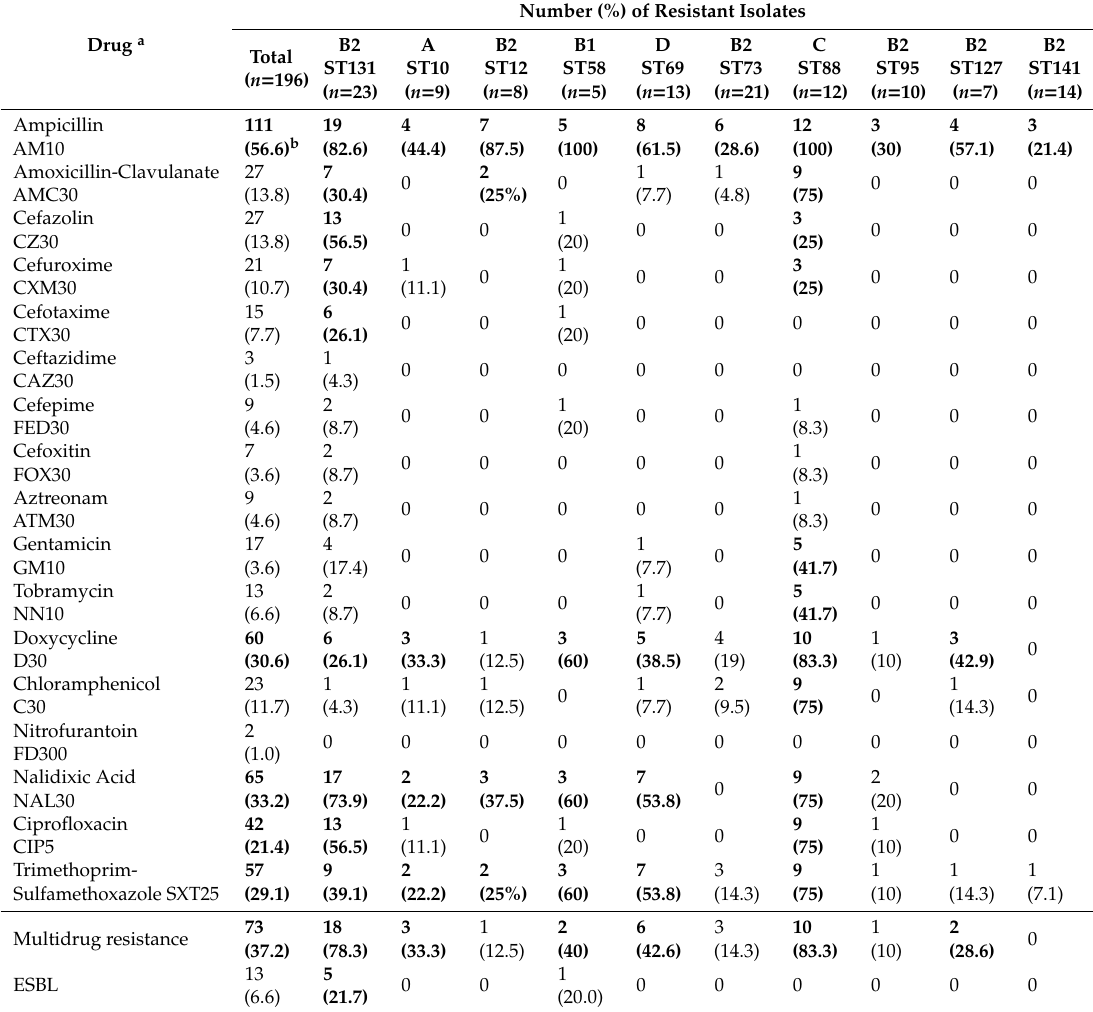
Table 3. Antimicrobial resistance observed from the 196 isolates and the isolates included in the 10 most frequent sequence types.